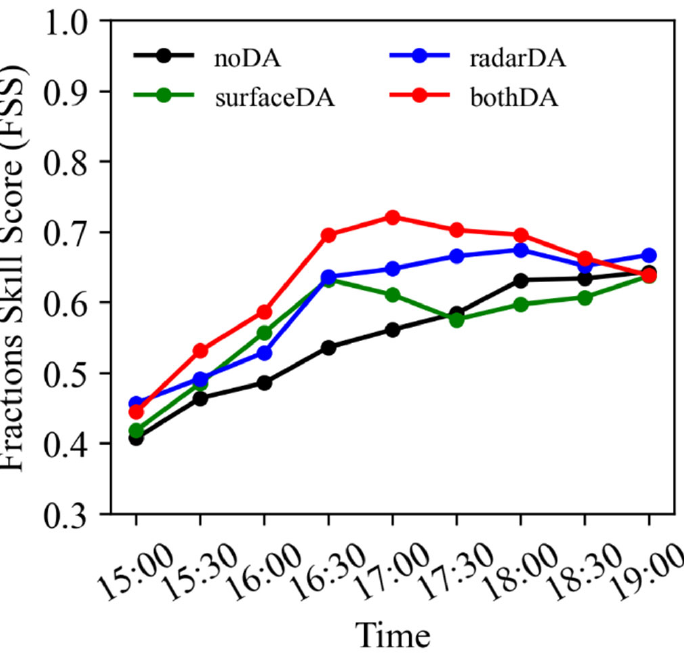
Figure 6. The averaged fractions skill scores (FSS) of the radar composite reflectivity at different thresholds (10, 15, 20, 25, 30, 35, 40, 45, 50 dBZ) from 1500 UTC to 1900 UTC 11 July 2014 for noDA (black dotted line), radarDA (blue dotted line), surfaceDA (green dotted line) and bothDA (red dotted line) experiments. The score area is the same as the panel area in Figure 5.